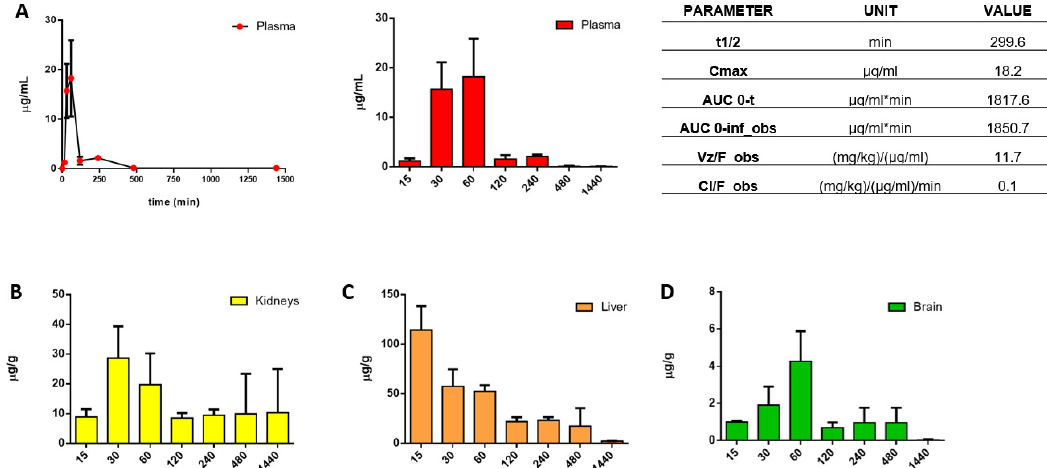
Figure 8. PK and biodistribution of BA103 in BALB/c mice at the single dose of 50 mg/kg i.p. ( A ) Plasmatic distribution and PK parameters. Concentration levels ± SD of BA103 in ( B ) kidneys, ( C ) liver, and ( D ) brain. Table 4. In vitro ADME evaluation of selected compounds [a]